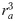
Murray’s law and equal bifurcation leads to scaling of vessel diameter.(a) Murray’s law states that cubic sum of influx arterial radius
ra3 should be equal to the cubic sum of the efflux vessel radii rb3+rc3+rd3... [14]. (b) When the tree structure is generated by equal bifurcation under Murray’s law, it is possible to explicitly obtain the number and radius of the n + 1th bifurcation. (c) Each blood vessel segment radius and number should show linearity on a log–log plot, and the gradient should be −3 [16]. (d) Incomplete bifurcation. In the real retina, the arterial tree did not form a complete bifurcation tree. If we assume that the bifurcation occurs at probability q, the number of thin branches decreases, resulting in a smaller gradient. (e) Relationship between bifurcation probability q and gradient. When q is less than 1, the gradient is larger than −3.